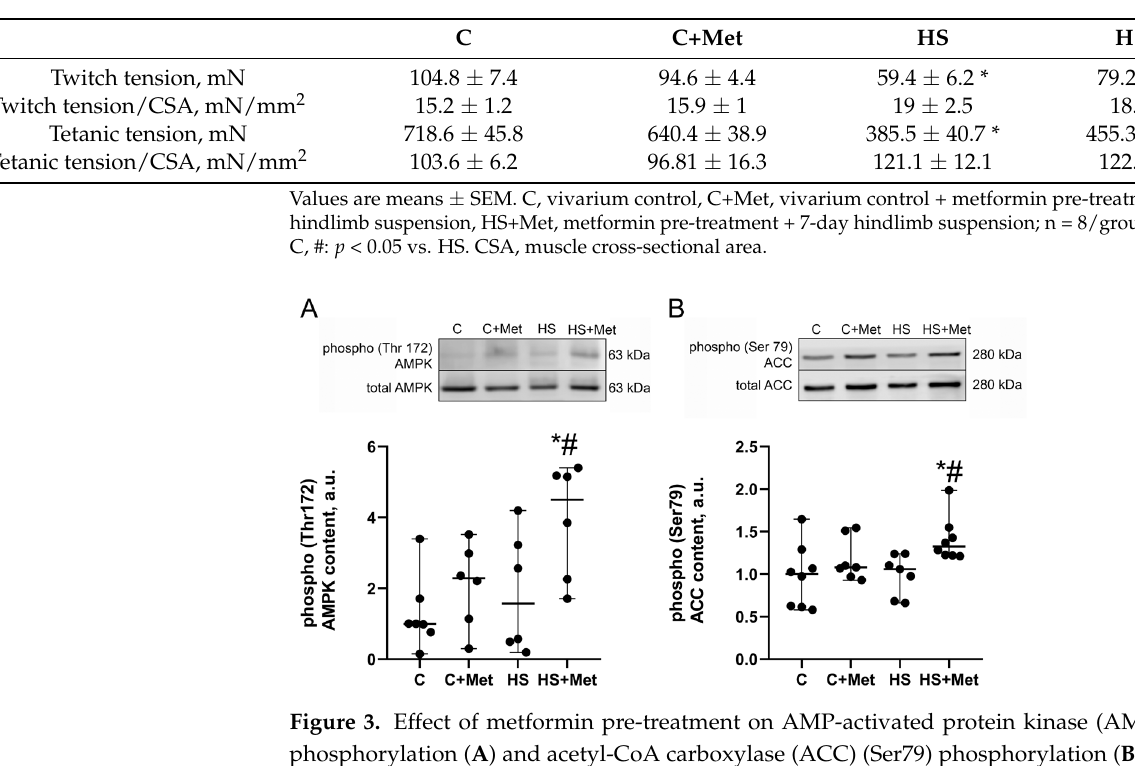
Figure 2. Minimal Feret’s diameters of slow-type ( A ) and fast-type ( B ) soleus muscle fibers. C, vivarium control, C+Met, vivarium control + metformin pre-treatment, HS, 7-day hindlimb suspension, HS+Met, metformin pre-treatment + 7-day hindlimb suspension. Scatter dot plots indicate median values, and the whiskers represent minimum and maximum values; n = 8/group. *: p < 0.05 vs. C, #: p < 0.05 vs. HS. Table 3. Changes in the absolute and normalized twitch and tetanic tension in the isolated rat soleus muscle.